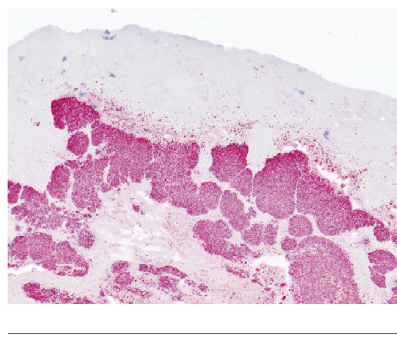
Figure 1. Transthoracic echocardiography showing two large vegetations (Veg), one at the aortic valve (right arrow) and one at the mitral valve (bottom arrow).